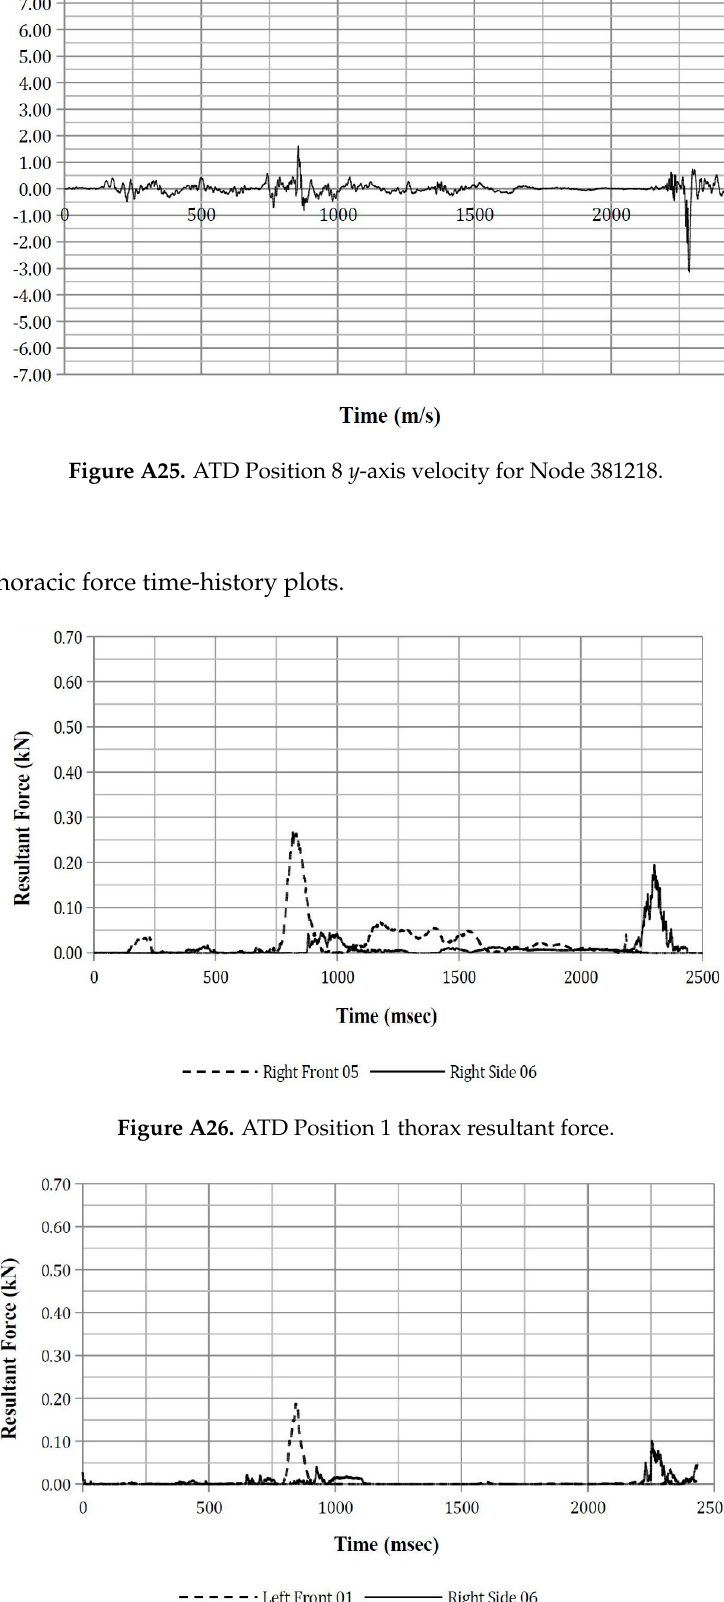
Figure A27. ATD Position 2 thorax resultant force.